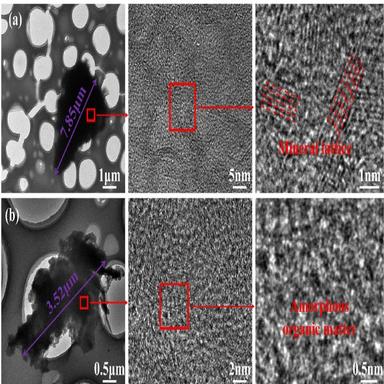
AFM scanning analysis of oil shale samples obtained via mechanical stripping. (a)e(b) Anisotropic distributions of organic matter at a scale of several nanometers. (c)e(d) Anisotropic distribution of organic matter at a scale of tens of nanometers.